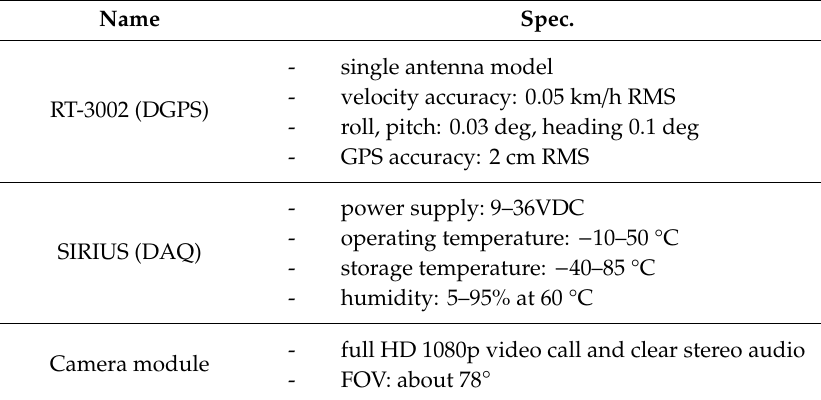
Table 2. Test measurement equipment